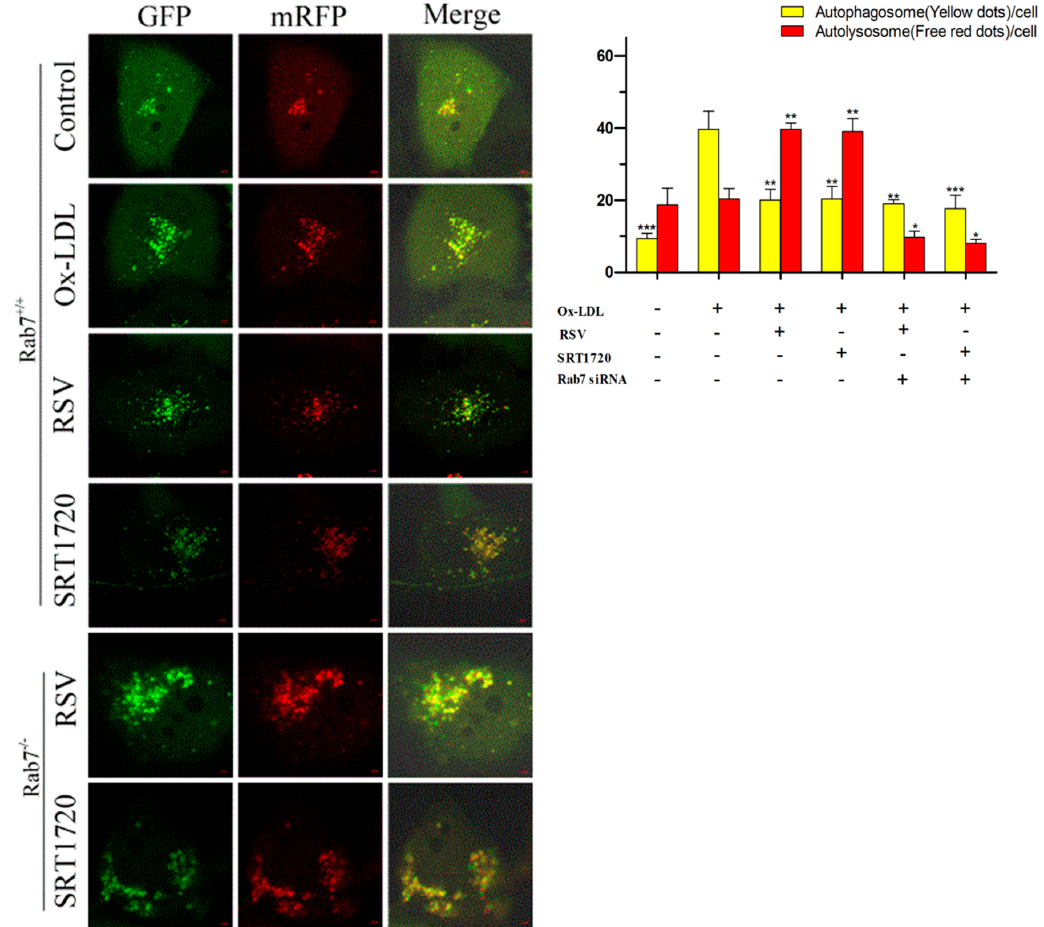
Figure 7. Effects of RSV or SRT1720 on autophagy flux in HUVEC treated with ox-LDL. HUVEC were transfected with mRFP-GFP-LC3 adenoviral particles (MOI = 50) for 48 h and transfected with Rab7 siRNA for 24 h, during which HUVEC were cultured with 100 μ g/mL ox-LDL and 10 μ M RSV or 5 μ M SRT1720 for 12 h. The formation of autophagosome (yellow fluorescence) and autolysosome (red fluorescence) was detected by confocal microscopy (Scale bar, 5 μ m, 63 × 10 magnification). Values are presented as the means ± SD ( n = 15). Statistical significance between the ox-LDL treated group and other groups was determined by one-way ANOVA: Compared with the ox-LDL group, * p < 0.05, ** p < 0.01, *** p < 0.001.